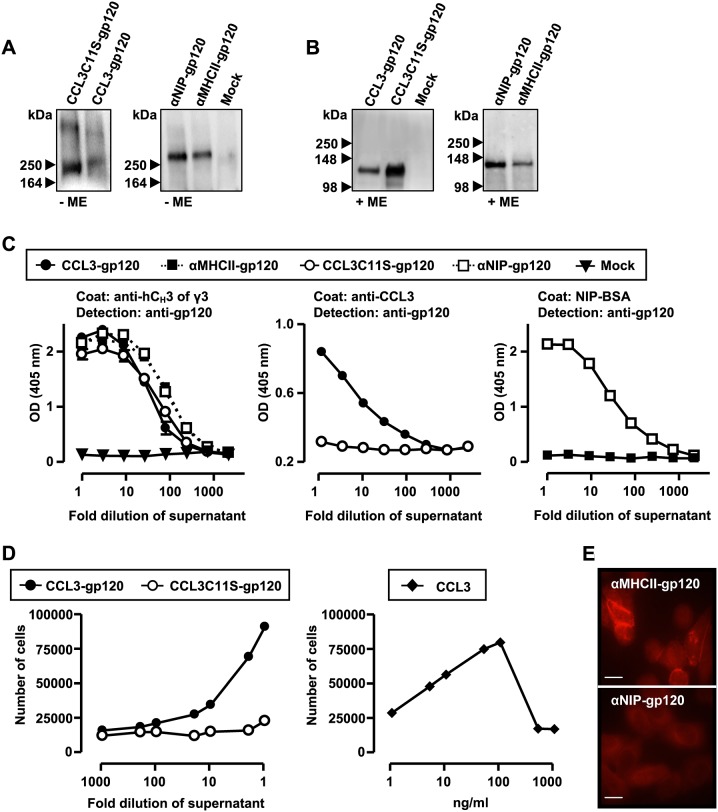
Characterization of the gp120-containing vaccibodies.(A, B) SDS-PAGE (4–20% Tris-Glycine gel) and Western blotting of supernatants harvested from HEK293 cells transfected with DNA encoding the various vaccibodies indicated by their targeting unit. (Mock = supernatant from HEK293 transfected with DNA encoding a fluorescent protein). The supernatants were either left untreated (−ME) (A) or reduced with mercaptoethanol (+ME) (B) prior to SDS-PAGE and blotting. The vaccine proteins were detected by anti-human IgG antibodies (clone HP6017) and chemiluminescence. (C) The gp120-containing vaccibodies were produced and secreted by transfected cells. ELISA of supernatants harvested from HEK293 cells transfected with DNA encoding the vaccine constructs indicated in the figure. The antibodies used as coat and detection in the ELISAs are indicated above each graph. Similar results were obtained in multiple experiments, and one representative experiment is presented. (D) CCL3 inserted into the vaccibody format is chemotactic. Supernatants containing the indicated vaccine proteins (left graph) or recombinant CCL3 (right graph) were added to the bottom wells of Transwell plates. 600 000 Esb-MP cells (a murine T cell line that expresses CCR1 and CCR5) were added to the top wells and the number migrating through the membrane was determined by flow cytometry after 2 h. Representative results from one out of two experiments are shown. (E) αMHCII but not αNIP inserted into the gp120-containing vaccibody binds to MHC class II. Supernatants harvested from transfected HEK293 cells were used to stain MHC class II EβdEαk-transfected mouse fibroblasts. The bound vaccine proteins were detected by a CH3-specific antibody (clone HP6017) and fluorescence microscopy. Scale bar, 10 µm.